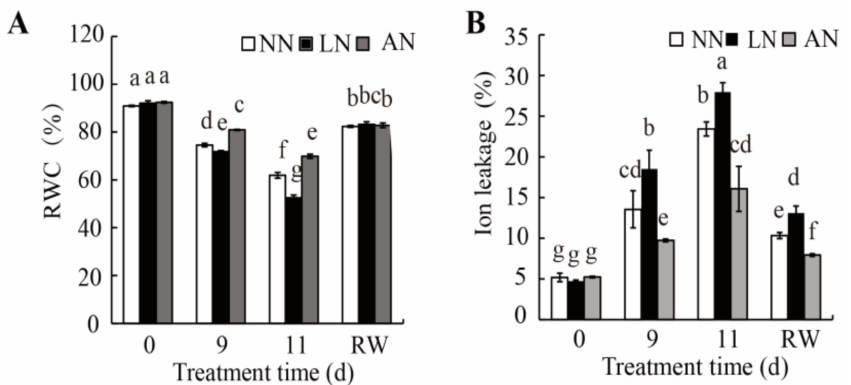
Figure 2. The effects of rhizobia inoculation on relative water content (RWC) and ion leakage in response to drought stress. Ninety-day-old A. sinicus plants were withheld irrigation for drought stress treatment. RWC ( A ) and ion leakage ( B ) were measured at 0, 9, and 11 days after withholding irrigation and 2 days after rewatering (RW). AN, LN, and NN indicate the plants with active nodules, low-activity nodules, and no nodules, respectively. The data presented are means and standard errors of three replicates, and the same letter above the column indicates no significant difference at p < 0.05.